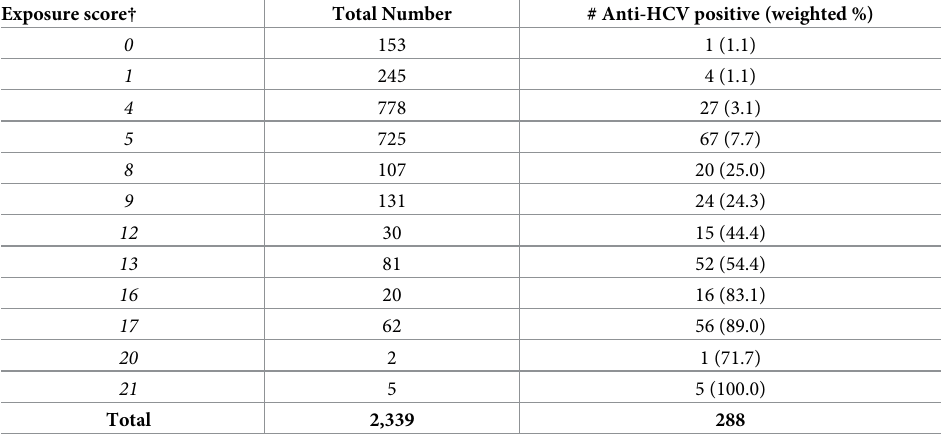
Table 4. Proportions of anti-HCV positive participants in each of the exposure score categories among males, Georgia HCV serosurvey, 2015.